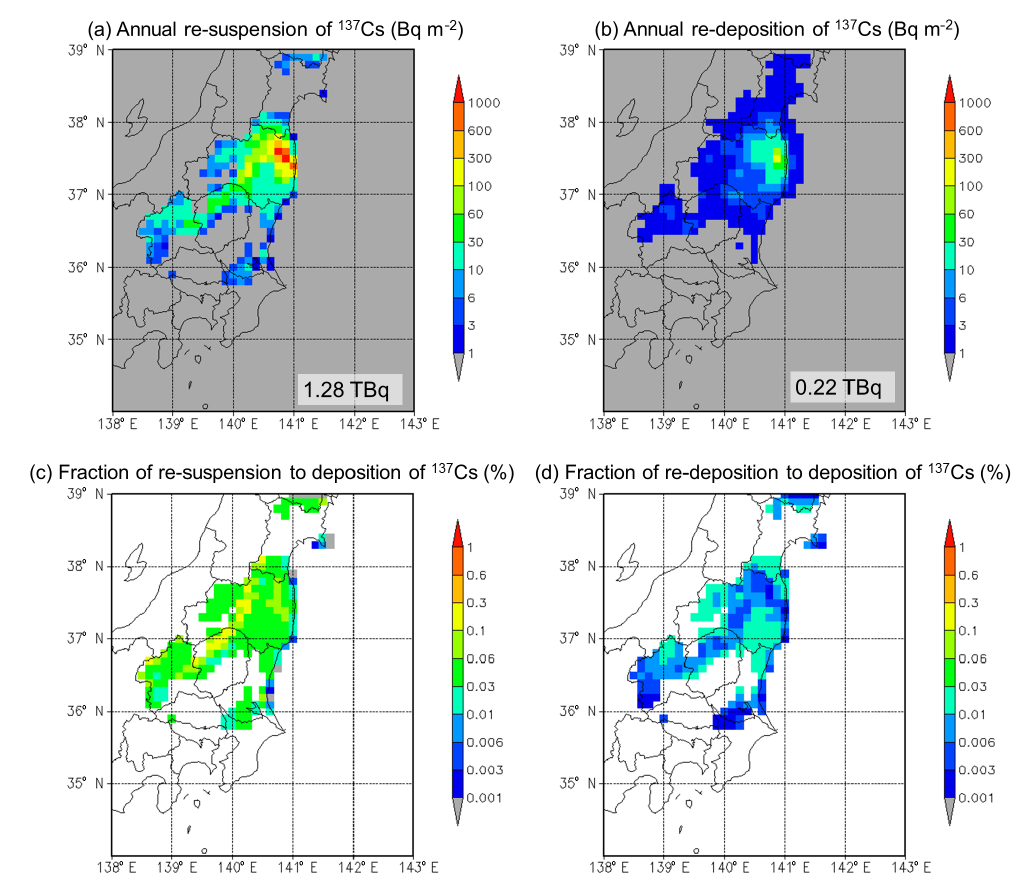
Figure 8. Annual total amounts of (a) the re-suspension and (b) the re-deposition of 137 Cs. The total activities are presented as numbers. Fractions of the re-suspension and the re-deposition to the observed 137 Cs deposited amounts are also shown in (c) and (d) , respectively. The deposition parameters of the simulation in the figure are E c = 0.04 and v d = 0.1cms − 1